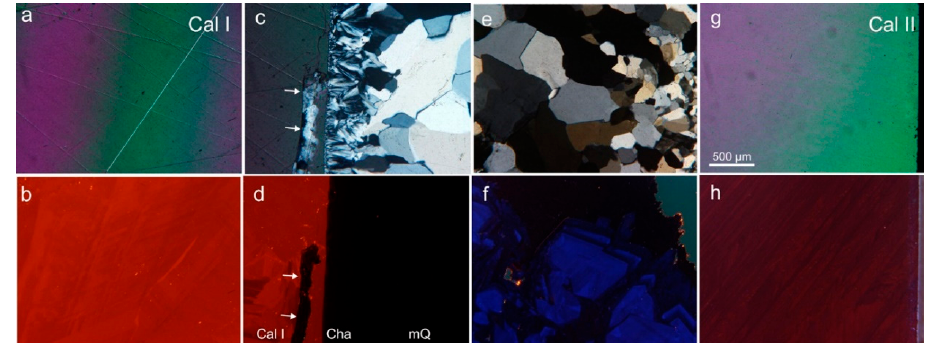
Figure 12. Micrographs of secondary minerals in polarized light (upper) and cathodoluminescence (lower). ( a , b ) Calcite of the first ‐ generation Cal I showing growth zoning under CL—the orange CL is caused by Mn 2+ activation. ( c , d ) Transition zone Cal I ‐ SiO 2 mineralization starting with spherulitic chalcedony (Cha)—the arrows point to corrosion of Cal I by SiO 2 . ( e , f ) Macrocrystalline quartz (mQ) showing remarkable growth zoning under CL—the characteristic transient blue CL points to hydrothermal origin. ( g , h ) Homogeneous calcite of the second ‐ generation Cal II with regular growth zoning under CL—the Mn 2+ ‐ activated CL intensity is much lower than in Cal I (note that exposure time for b,d is 1 s and for f,h 20 s.